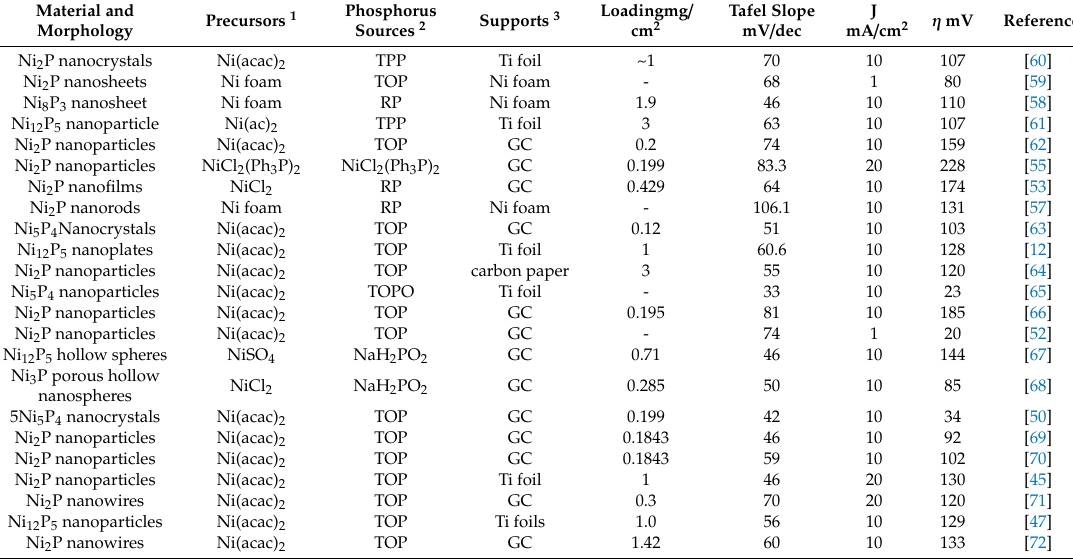
Figure 5. XRD patterns of ( a ) the as-fabricated Ni 2 P-NRs / Ni composite electrode, ( b ) SEM image, ( c ) Dark-field, and ( d ) bright-field TEM micrographs of Ni 2 P-NRs. ( e ) HRTEM image of a single Ni 2 P-NR. Inset: FFT-ED pattern. ( f ) HAADF STEM image of a single NR and the corresponding EDX elemental maps of Ni, P, and Ni + P. ( g ) Polarization curves for Ni 2 P-NRs/Ni composite electrode in 0.5 M H 2 SO 4 . ( h ) The Corresponding Tafel plots. Reproduced with permission from Reference [57]. Copyright the Royal Society of Chemistry, 2015. Table 1. Summary of the nickel phosphide electrocatalysts prepared through a solution-phase method for HER in an acidic